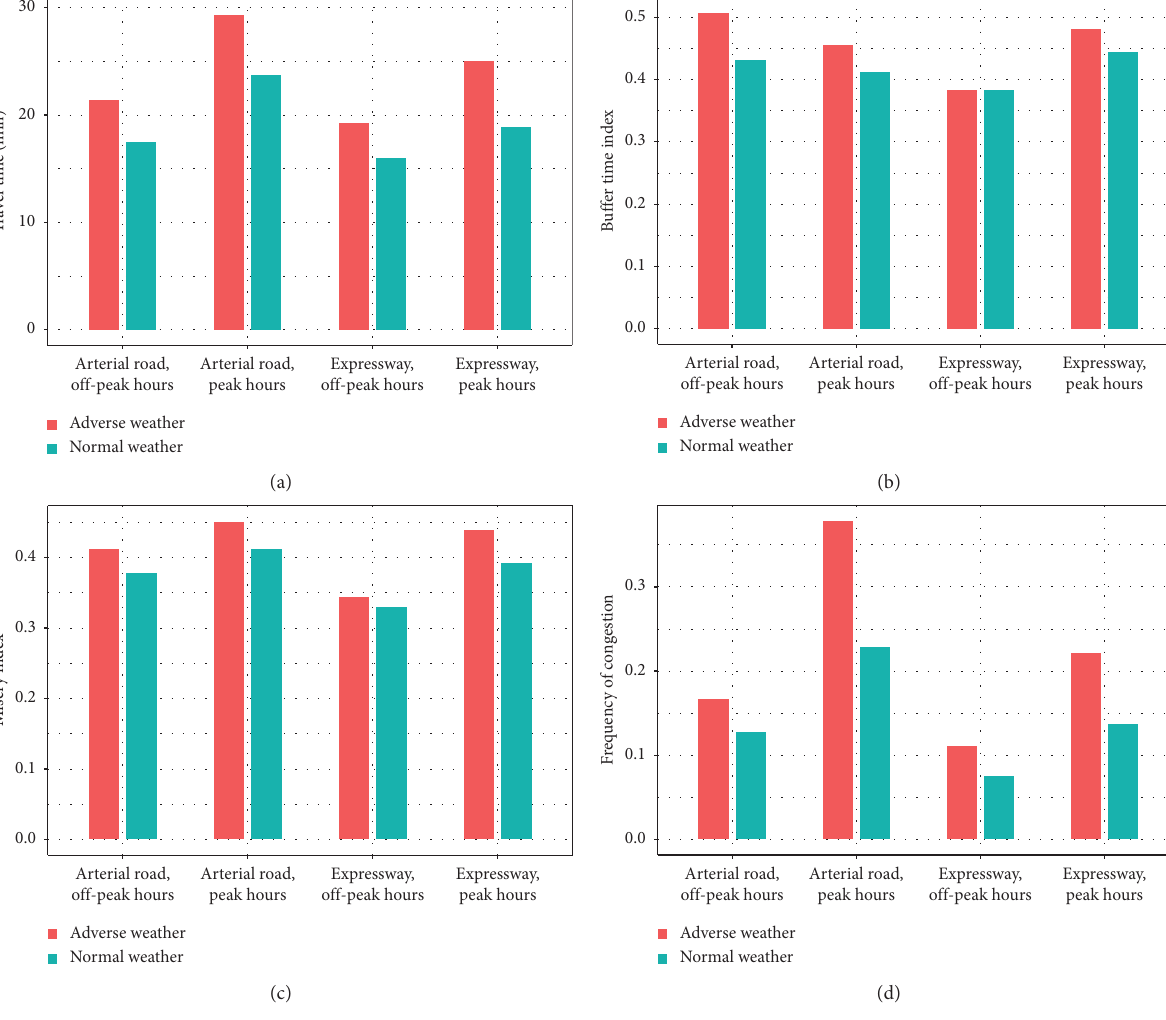
Figure 7: TTV, BTI, MI, and FOC under different scenarios. (a) TTV, (b) buffer time index, (c) misery index, and (d) frequency of Table 3: The increase of TTR measures under adverse weather condition.